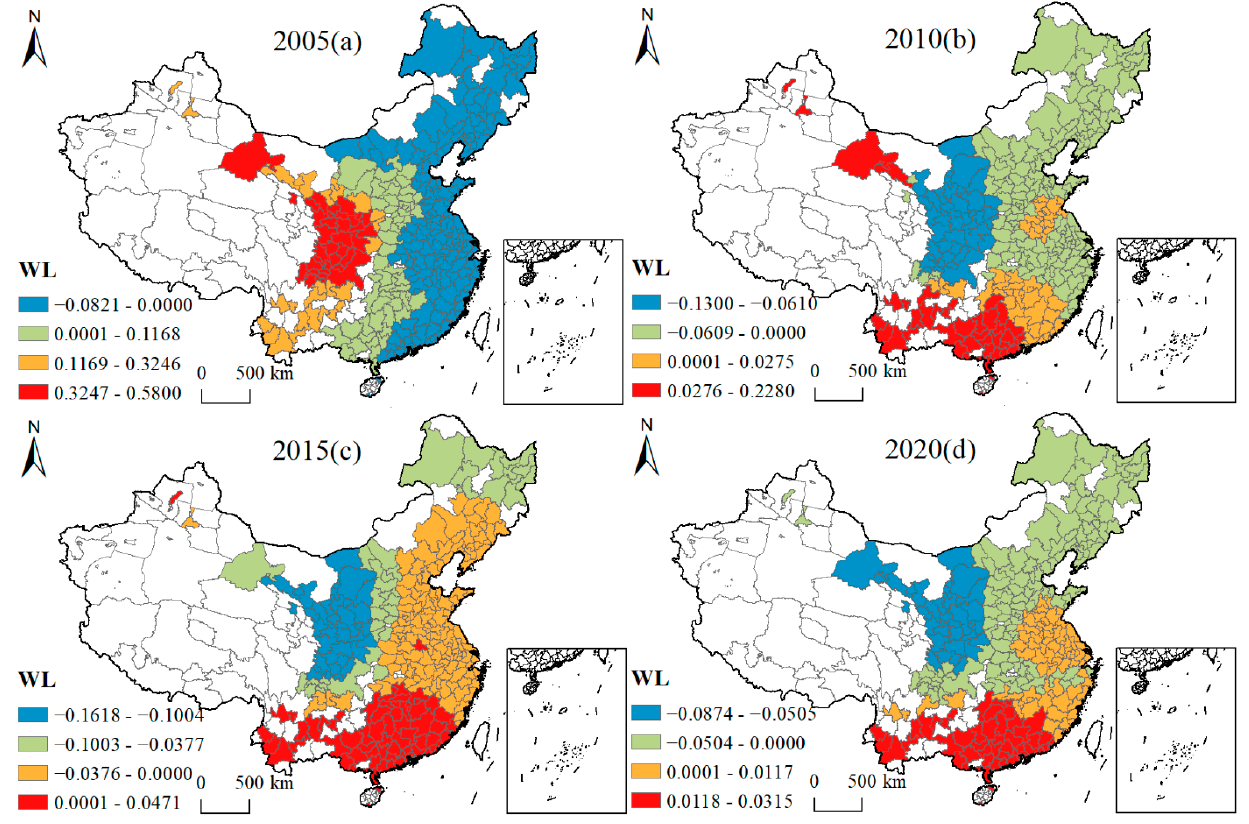
Figure 11. Four-year regression coefficients of WL.